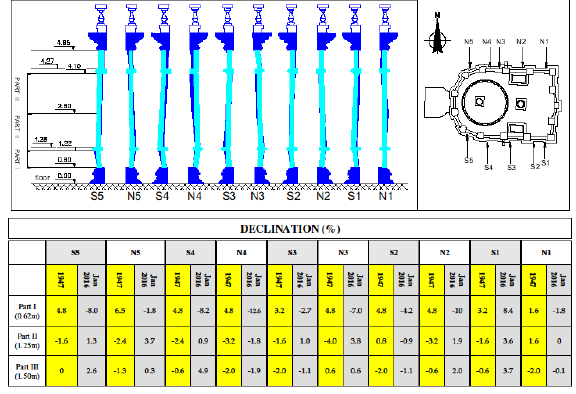
Figure 10: The change of the declination of the Holy Aedicule’s columns